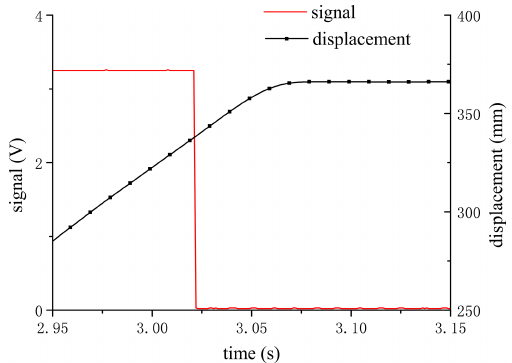
Figure 5. Displacement curve of the piston rod braking with the initial velocity of 700mms − 1